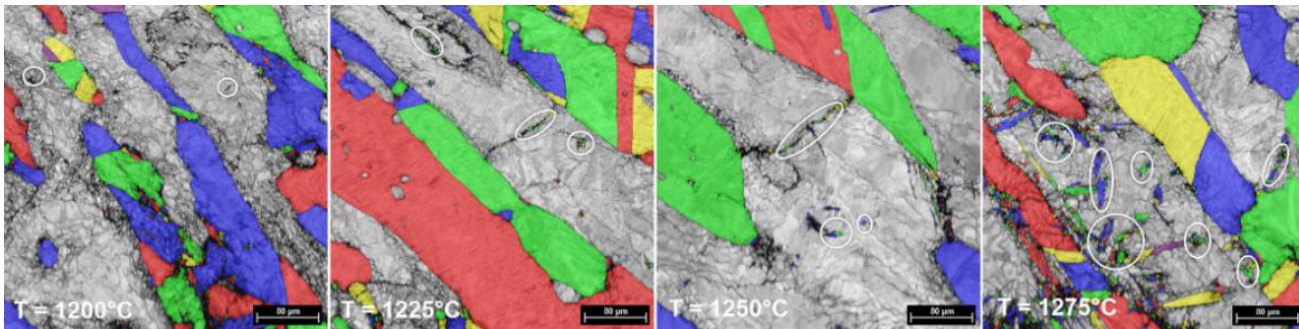
Figure 8. Typical random-colorized γ-phase grain size distribution maps in hot-deformed UNS S32750 SDSS alloy (from 1200 °C to 1275 °C).